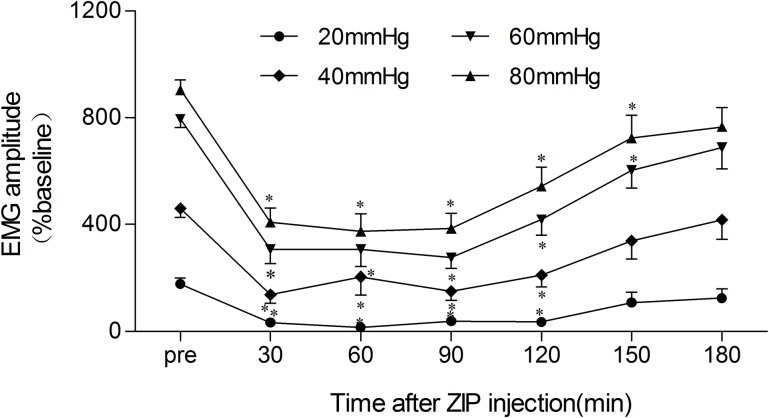
The duration curve of the inhibitory effect of intrathecal ZIP injection on visceral hypersensitivity in IBS-like rats.Duration curve of the inhibitory effect of 10 μg ZIP on EMG at 20–80 mmHg of CRD in IBS-like rats. The maximal suppression was recorded at 30 minutes after ZIP injection in IBS-like rats. The EMGs under 20–80 mmHg CRD were significantly decreased at 30–90 minutes after 10 μg ZIP injection; n = 10, respectively. *p < 0.05 vs. pre-drug. EMG: electromyography; IBS: irritable bowel syndrome; CRD: colorectal distention; ZIP: PKMζ inhibitor.